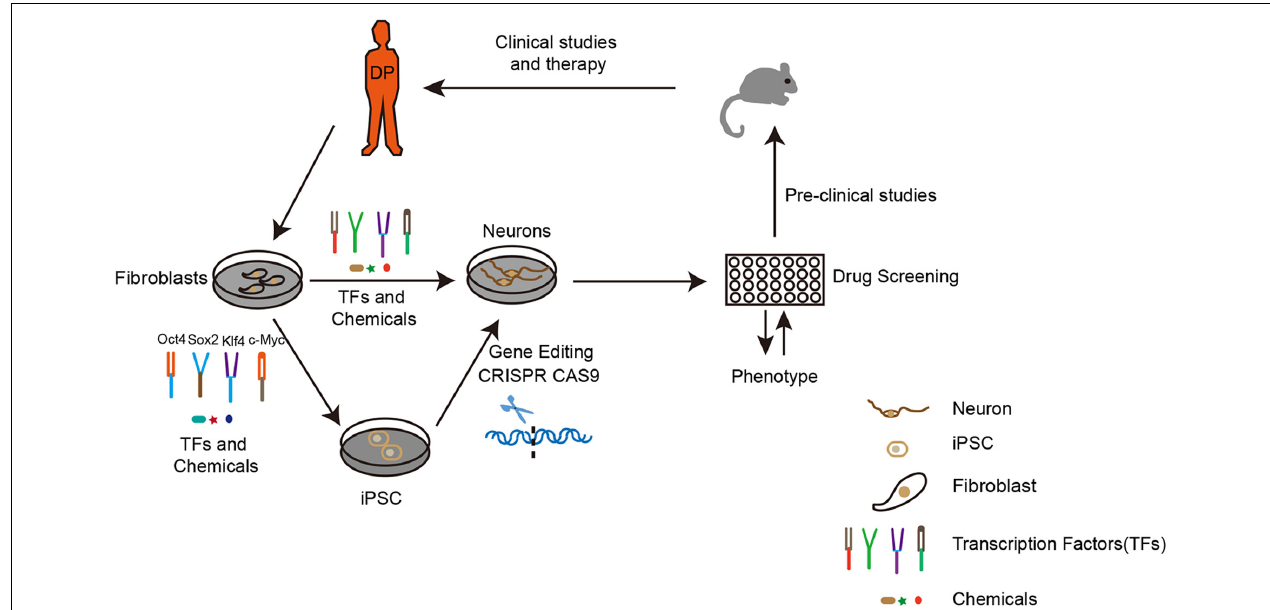
FIGURE 1 | The route to apply iPSCs and iN technology for neurodegenerative disease modeling and drug discovery. To establish an in vitro disease model, the first step is to obtain fibroblasts from a diseased person. Upon overexpression of certain transcription factors, fibroblasts can be directly or indirectly reprogrammed to neurons. Depending on research purposes, the fibroblasts from original iPSCs can be modified by gene editing (CRISPR CAS9). The neurons generated would be applied for drug screening according to the disease phenotype. Subsequently, the best candidates could then be used for pre-clinical studies on drug toxicity, bio-availability, pharmacology, and metabolism in animals. Finally, the potential drug would be used for clinical studies and therapy. DP: disease person.